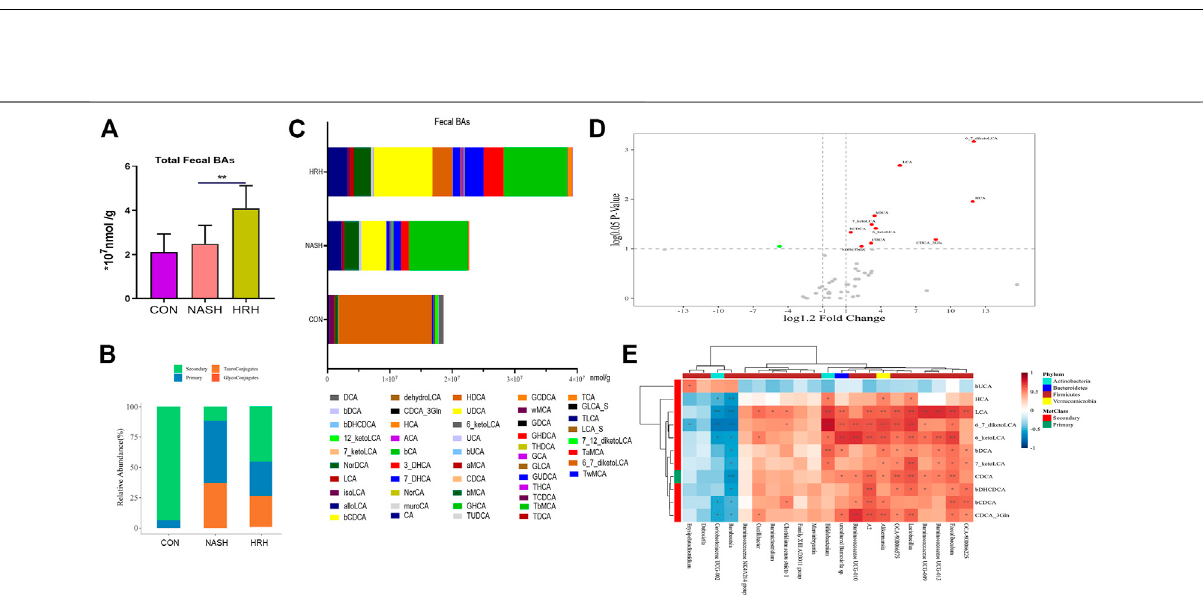
Frontiers in Pharmacology |